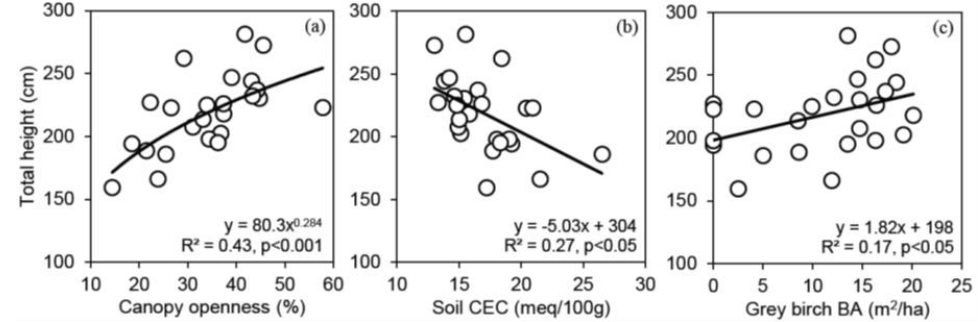
Figure 5. White pine ( Pinus strobus ) total height after 6 years in the tree shelter treatment as a function of ( a ) canopy openness, ( b ) soil cation exchange capacity (CEC) and ( c ) basal area (BA) of grey birch ( Betula populifolia ) in the overstory. N = 25 plots for each relationship.